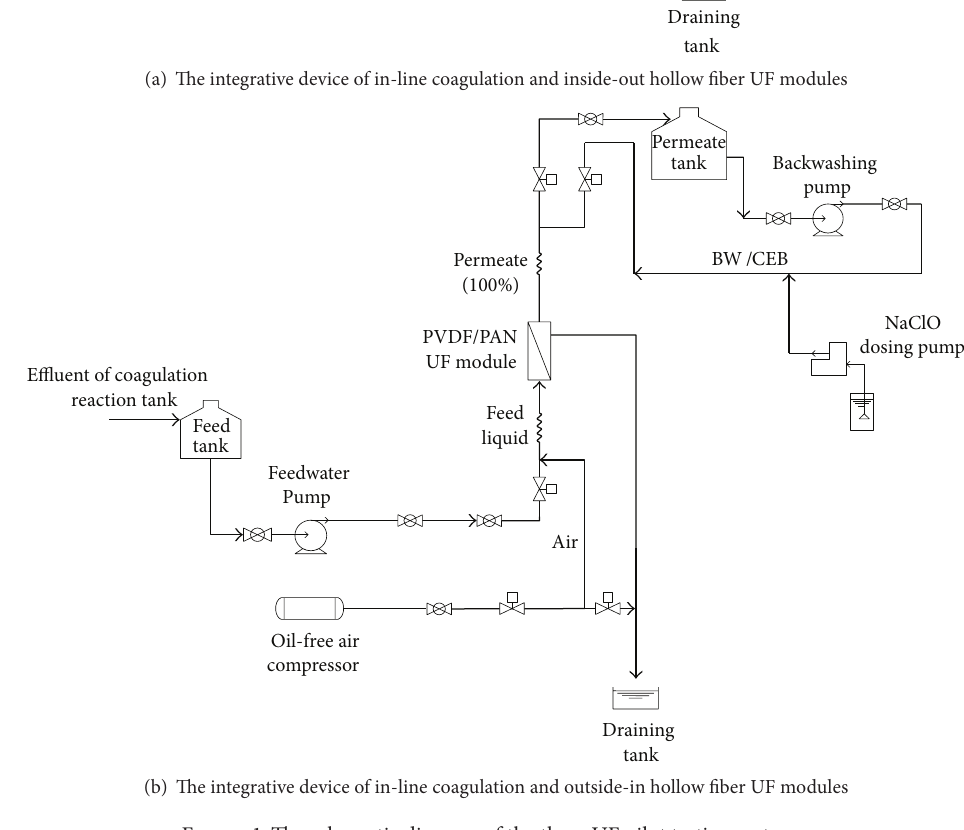
Figure 1: The schematic diagram of the three UF pilot testing